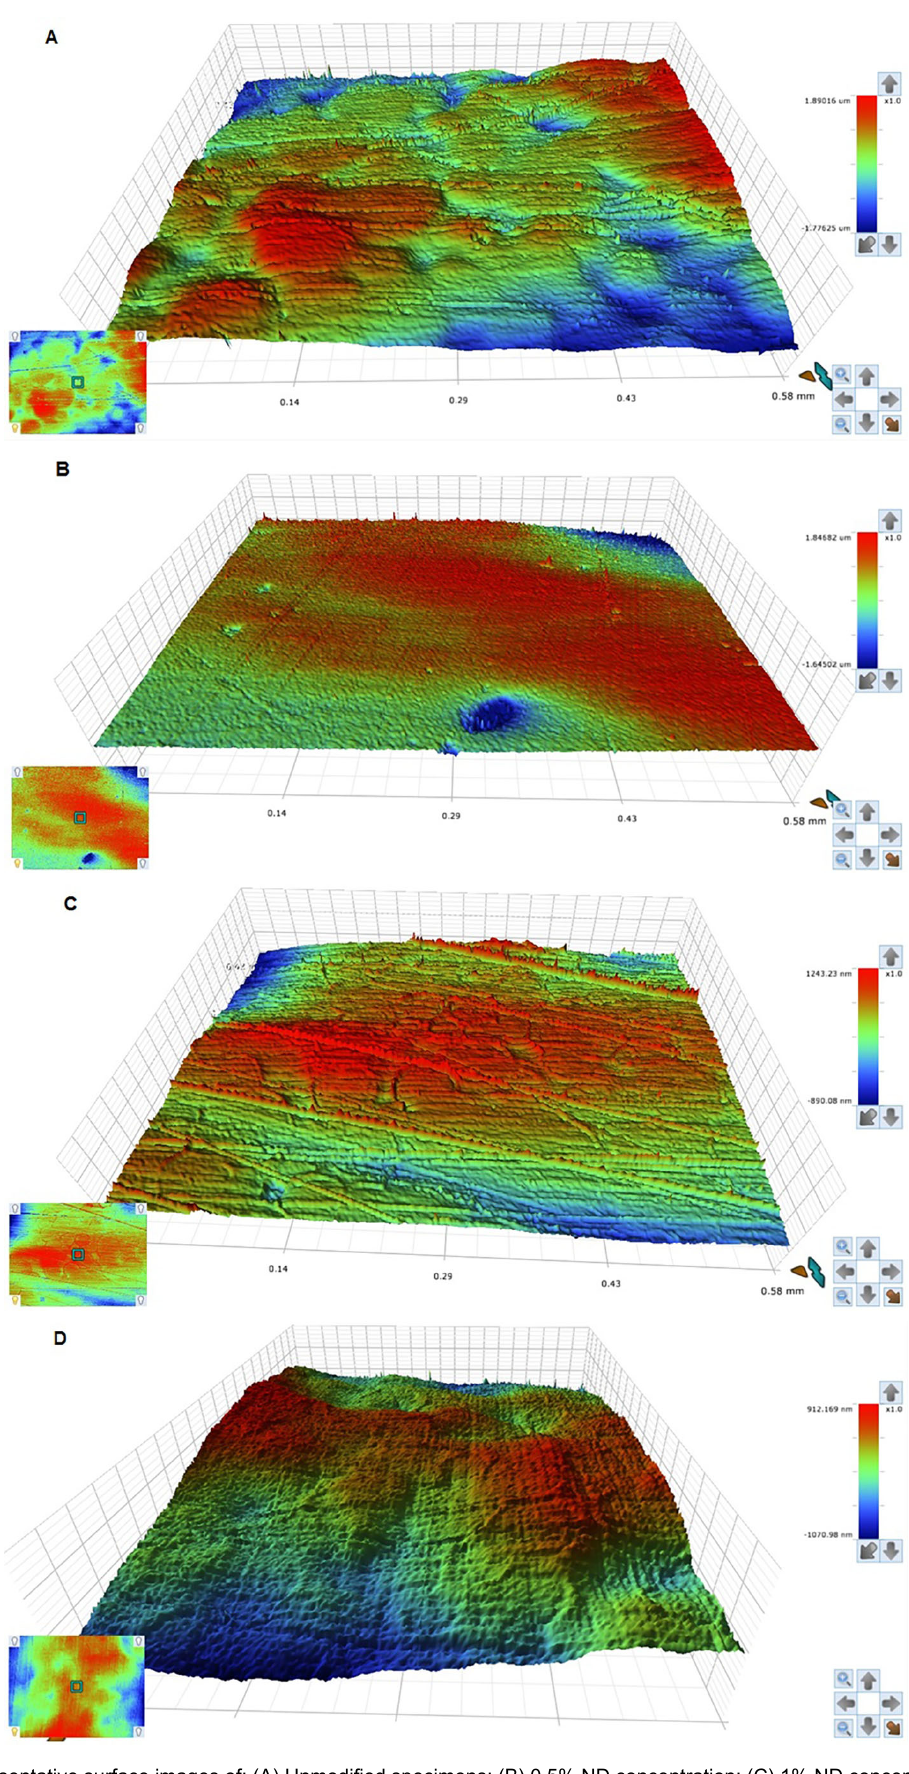
Figure 2- Representative surface images of: (A) Unmodified specimens; (B) 0.5% ND concentration; (C) 1% ND concentration; (D) 1.5% ND